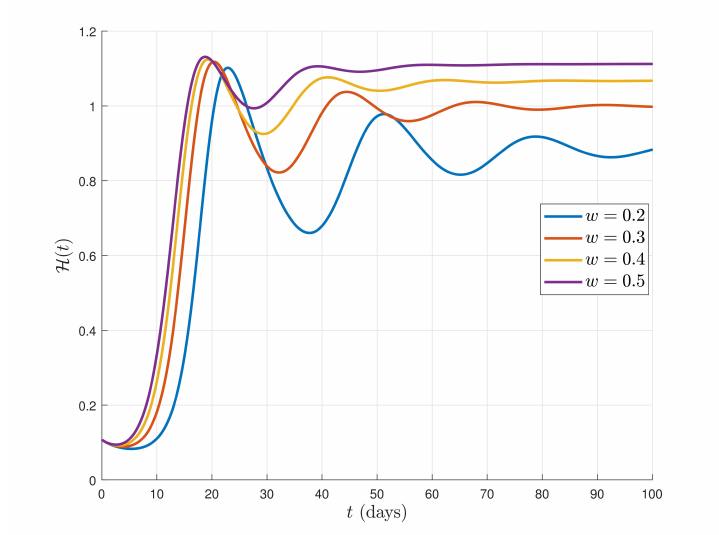
Figure 13. Effects of contact rates on state functions: H ( t ) versus ω